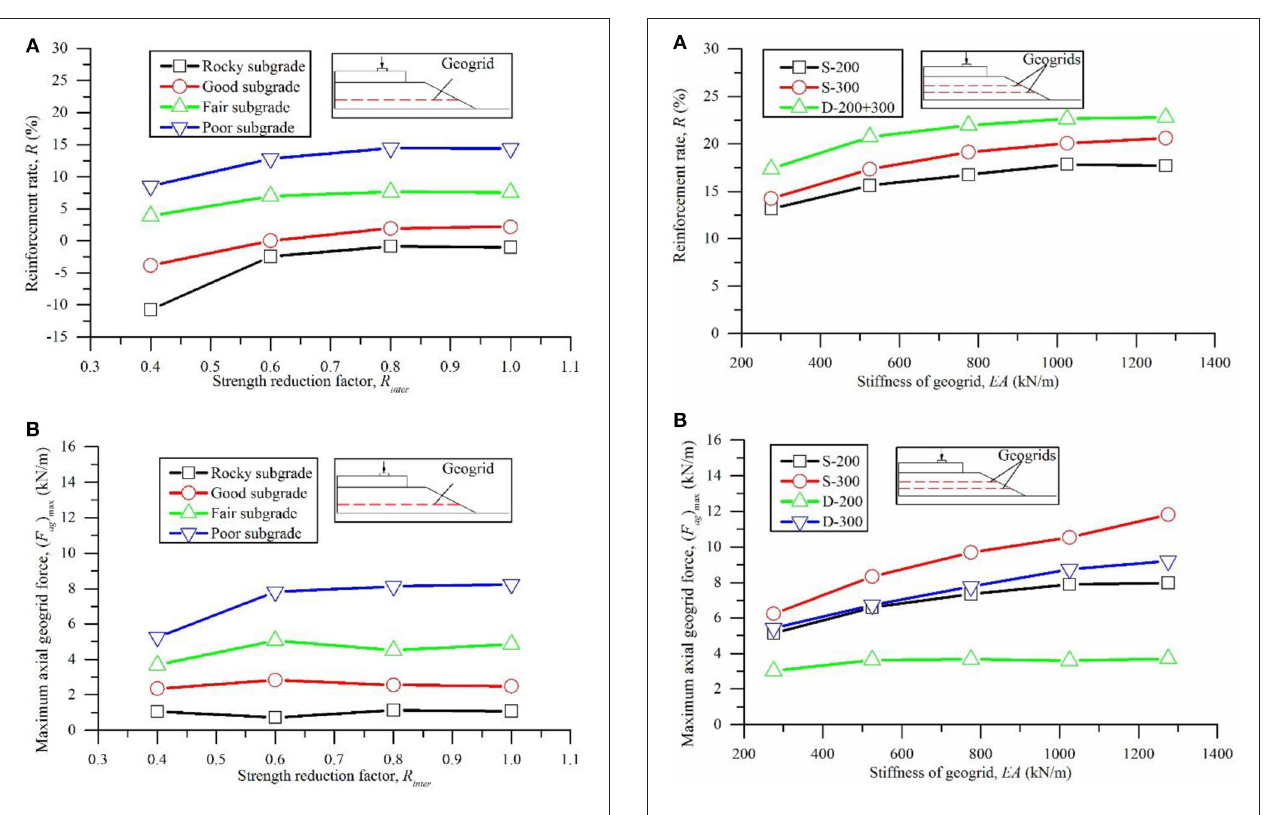
FIGURE 7 | Reinforcement rate and maximum axial force in geogrids with respect to the factor of strength reduction factor (Case 5): (A) reinforcement rate; (B) maximum axial geogrid force.